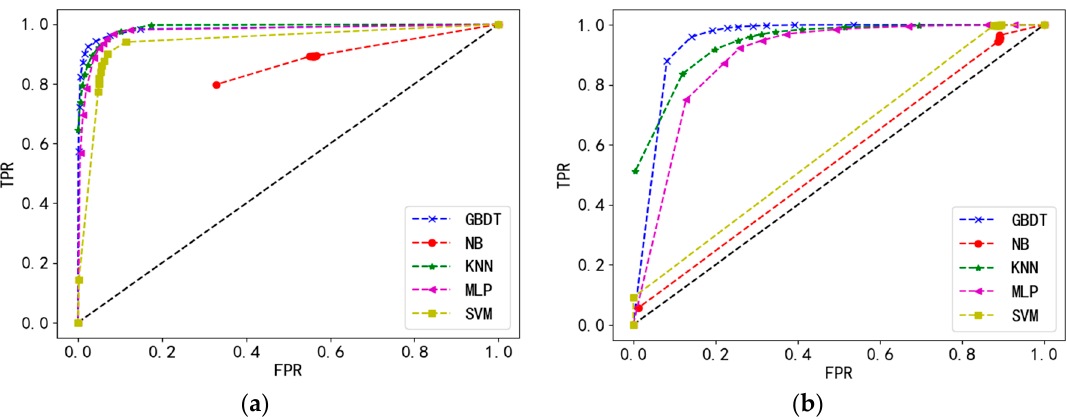
Figure 5. ROC curve comparison. ( a ) ROC comparison of TCP flow datasets; ( b ) ROC comparison of UDP flow datasets.